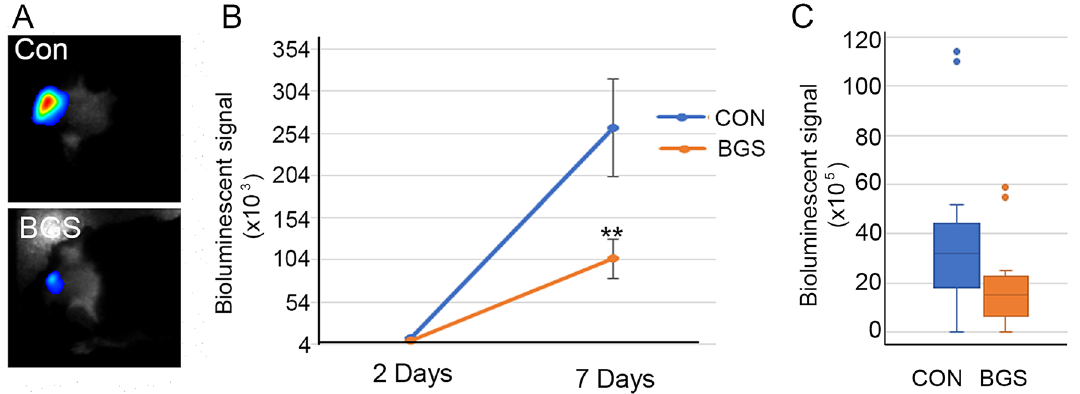
Figure 2. Reduction in tumor size in BGS treated mice. Animals were injected with Luc2-mCherry-labeled RET melanoma cells (5 × 10 3 /2 μl) and examined by bioluminescence imaging at day 2, 7 and 14 after the i.c. cell implantation. ( A ) A representative image of 7 days. ( B ) BGS treated animals show a significant decrease in tumor size at day 7 post implantation compared to the vehicle-control mice. ( C ) BGS treated animals show a trend (not significant) of a decrease in tumor size at day 14 post implantation compared to the vehicle-control mice. Results are expressed as mean ± SD with two-tailed unpaired Student t tests for day 2 and 7, and as median ± interquartile range with a Mann–Whitney U test for day 14 (n = 10 mice/group). Images on the left demonstrate a representative image of tumor size in BGS treated mice (lower panel) vs. untreated mice (upper panel) for day 7.